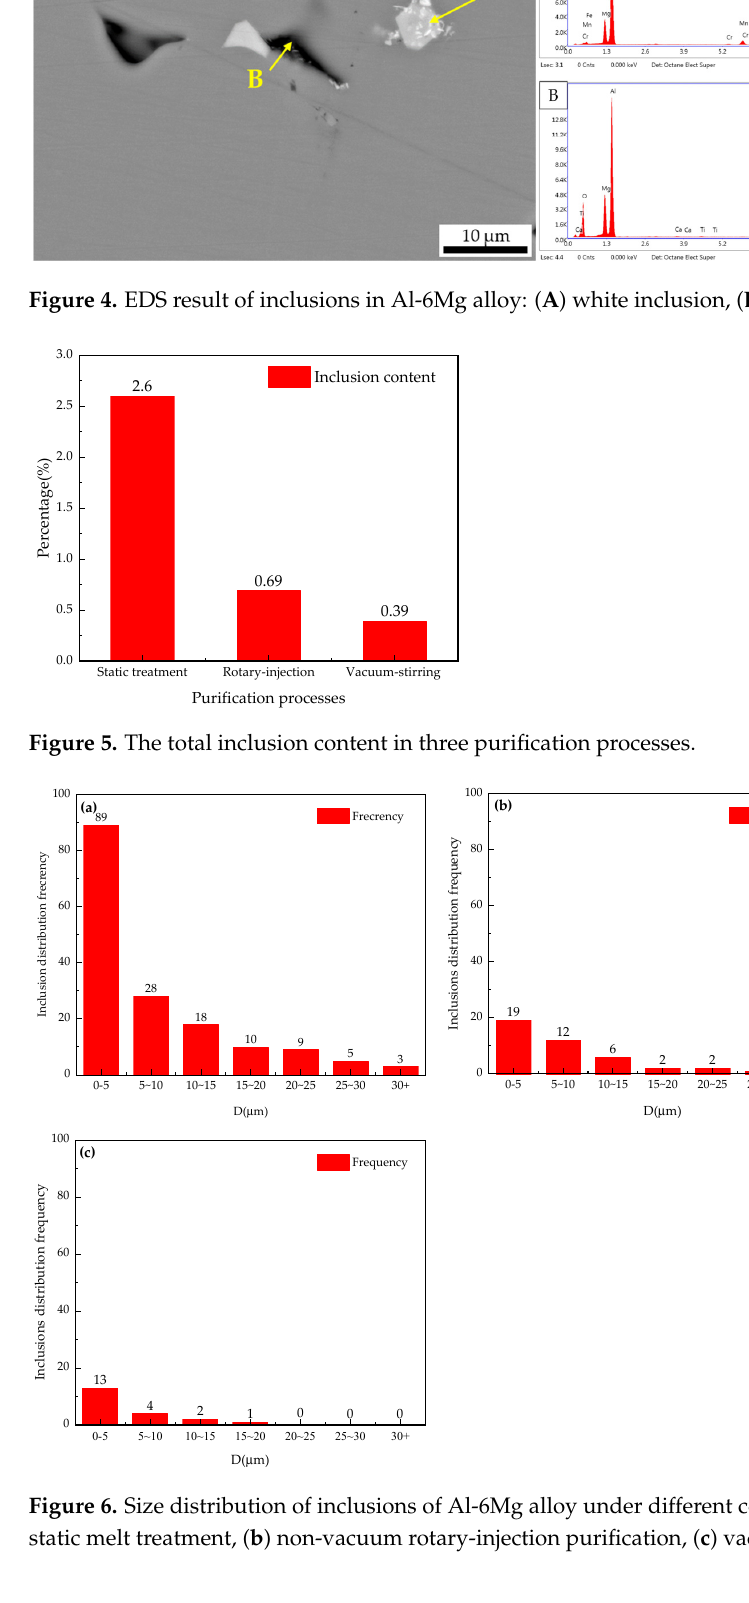
Figure 6. Size distribution of inclusions of Al-6Mg alloy under different conditions: ( a ) non-vacuum static melt treatment, ( b ) non-vacuum rotary-injection purification, ( c ) vacuum-stirring purification. It can be seen from Figures 5 and 6 that, in the case of non-vacuum static melt treat- ment, the total inclusion content accounts for 2.6% of the total field of view, the size dis- tribution of inclusion ranges from 0 to 30 μ m and the distribution frequency of above 10 μ m inclusions exceeds 40, as shown in Figure 6a. In the case of non-vacuum rotary-injec- tion purification, the total inclusion content accounts for 0.69% of the total field of view, the size distribution of inclusion ranges from 0 to 30 μ m and the distribution frequency of above 10 μ m inclusions decreases to 11, as shown in Figure 6b. In the case of vacuum- stirring purification, the total inclusion content accounts for 0.39% of the total field of view, the size distribution of inclusion ranges from 0 to 15 μ m and the distribution fre- quency of above 10 μ m inclusions decreases to 3, as shown in Figure 6c. 4. Discussion According to the melt purification effects mentioned above, the purification effects of melt under different purification processes are obviously different: the vacuum-stirring purification process is the best, the non-vacuum rotary-injection is inferior and the non- vacuum static melt treatment process is poor. It is well-known that the Al-6Mg alloy is of high Mg content, which is easy to oxidize and can easily absorb hydrogen, even if there is a thick oxide film on the melt covered with the aluminum alloy (i.e., when the melt was treated in the non-vacuum static melt treatment process, as shown in Figure 7a), so it is difficult to control the content of hydro- gen and inclusion. Compared to the non-vacuum static melt treatment, in the non-vacuum rotary-injec- tion purification process a steady stream of argon forms tiny bubbles in the melt, increas- ing the surface area of the bubble in contact with the melt, as shown in Figure 7b. The molecular hydrogen in the melt accumulates to the bubbles due to the local “negative pressure” formed by argon bubbles, and thus, the molecular hydrogen in the melt will be taken out continuously. According to literature [22], the disturbance of the rotor and the injected gas to the melt further reduces the limit solubility of hydrogen in the melt and improves the purity of the final melt. In addition, during the process of bubbles floating up, due to the existence of surface tension, the bubbles will also absorb small inclusions and float up to the surface of the melt. Although rotary injection can reduce the content of gas and inclusion in the melt to a certain extent, the melt surface is still in contact with the atmosphere, and it easily oxi- dizes to form a film, as shown in Figure 7b.